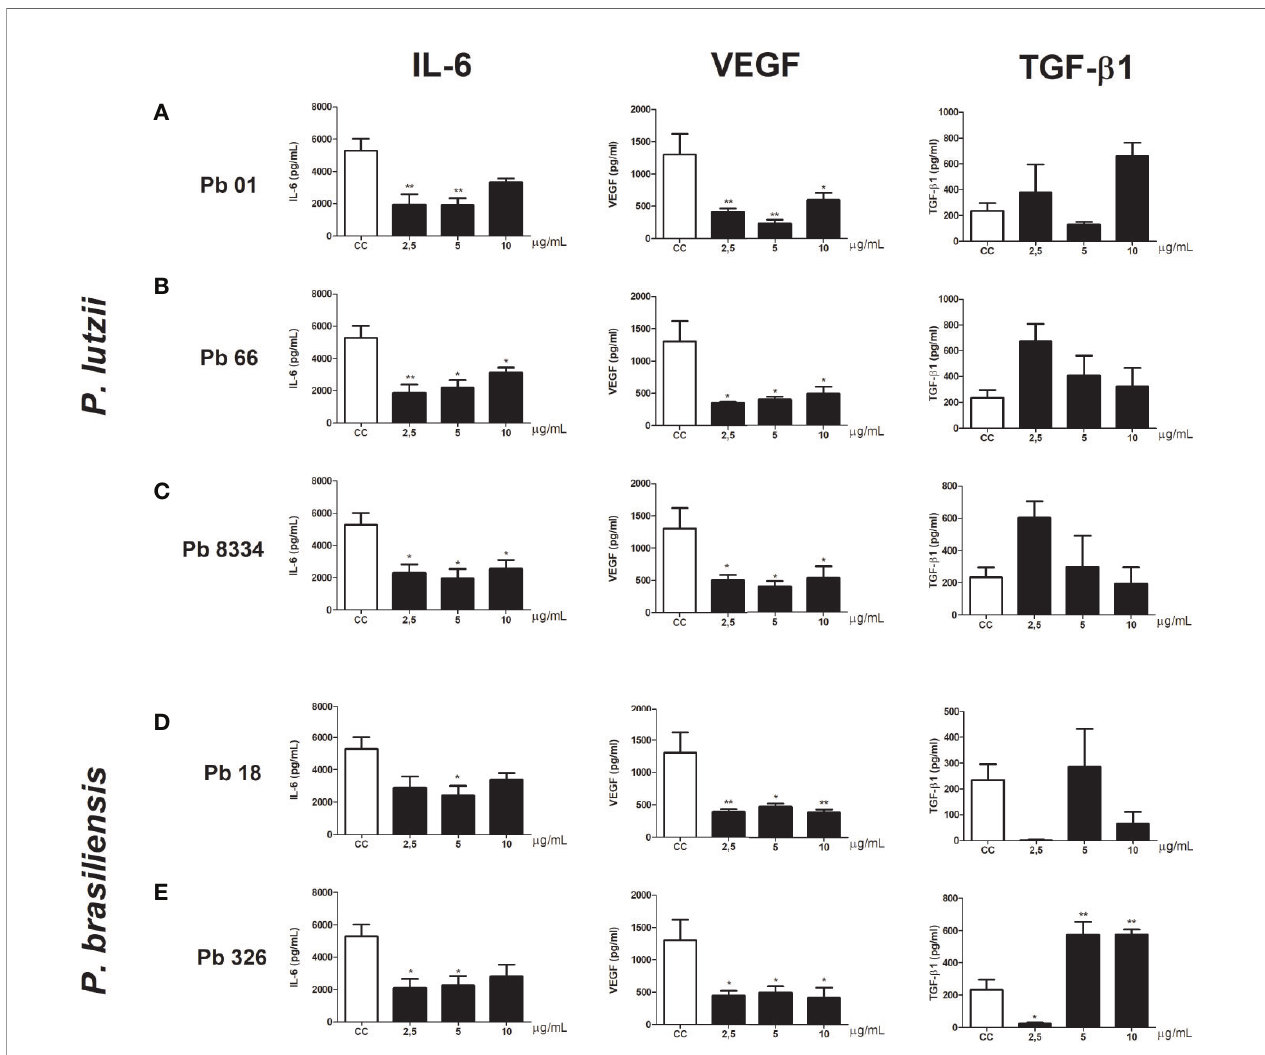
FIGURE 2 | Murine pulmonary fi broblast activity stimulated by Paracoccidioides spp. exoantigens. Fibroblasts were cultured in the presence or absence of Paracoccidioides spp. exoantigens and levels of IL-6, VEGF, and TGF- b 1 in the cell-free supernatants were determined 24 h post-treatment. (A) Pb01 exoantigen. (B) Pb66 exoantigen. (C) Pb8334 exoantigen. (D) Pb18 exoantigen. (E) Pb326 exoantigen. Results are expressed as means ± SEM; ANOVA with Dunnett ’ s post hoc test; * p < 0.05, ** p < 0.01; n =